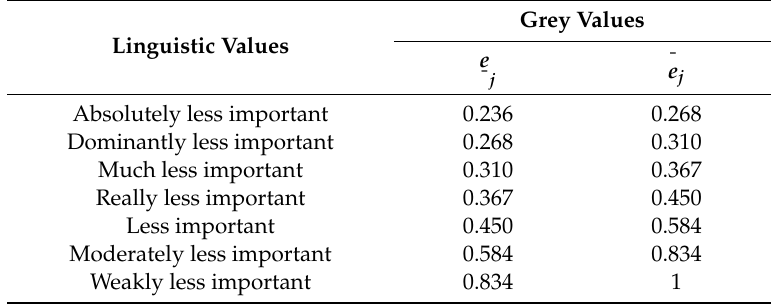
Table 1. The 0–1 scale for the evaluation of the criteria (adapted from Stevi´c et al. [33]). Linguistic